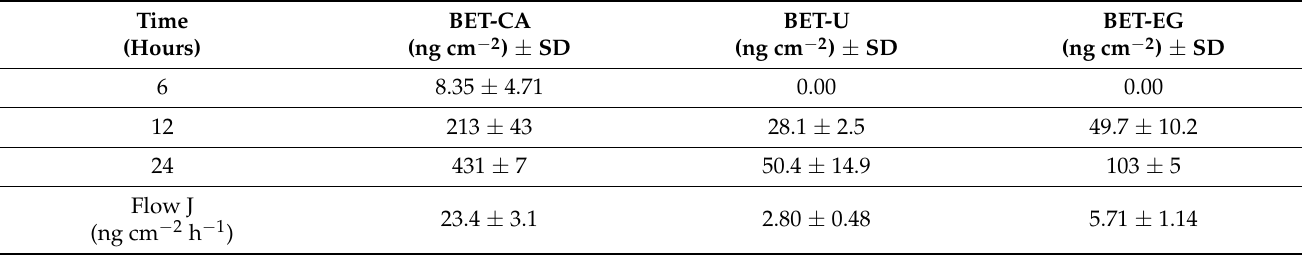
Table 1. Amounts of malvidin permeated (ng cm − 2 ) for the three tested formulations at 37 ◦ C.